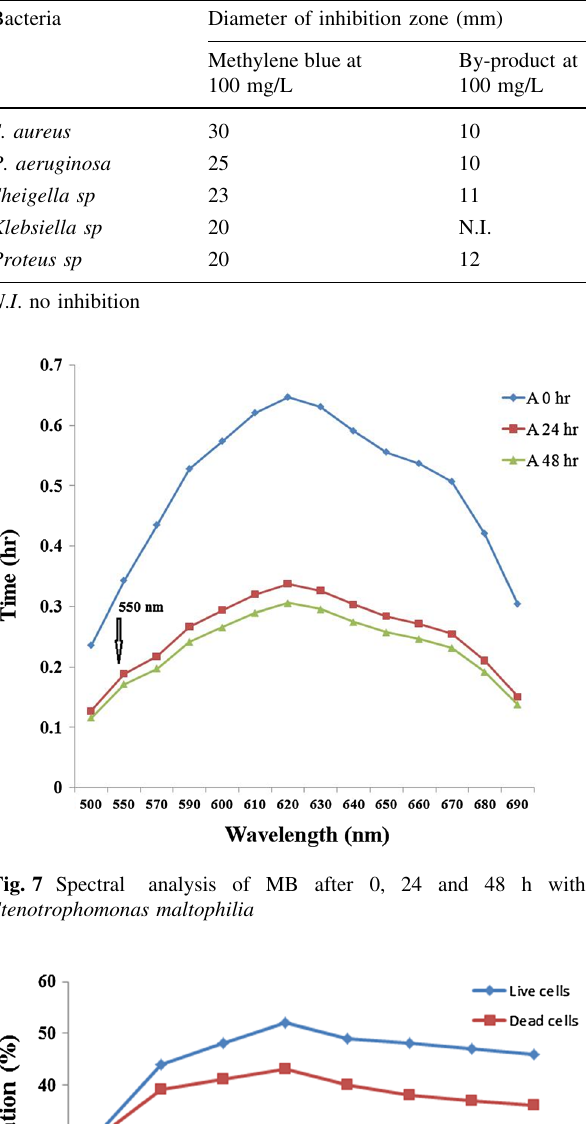
Table 1 Microbial toxicity study of methylene blue and metabolites obtained after decolorization Bacteria